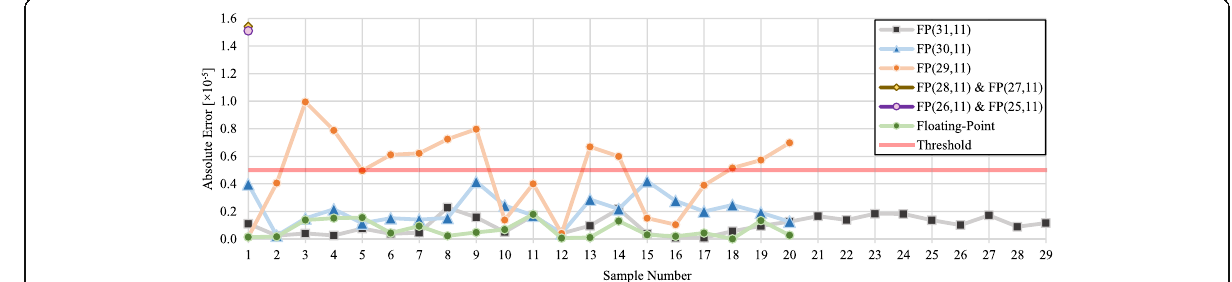
Fig. 11 Absolute error per sample for the investigated